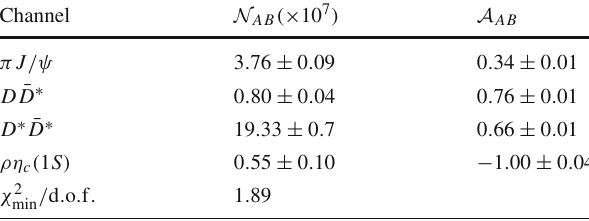
Table 1 Production amplitudes and normalization factors for the line shapes which are fitted using Eq. (20). The minimum value of the χ 2 / d . o . f . is also given. The 68%-uncertainties in the amplitudes and normalization factors are obtained from the fit